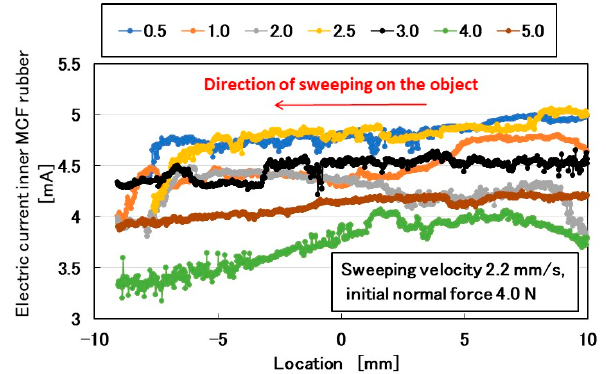
Figure 13. Electrical current of the MCF rubber sensor by rubbing silicone gel under shear motion at various ratio of the thinner to KE1300T.